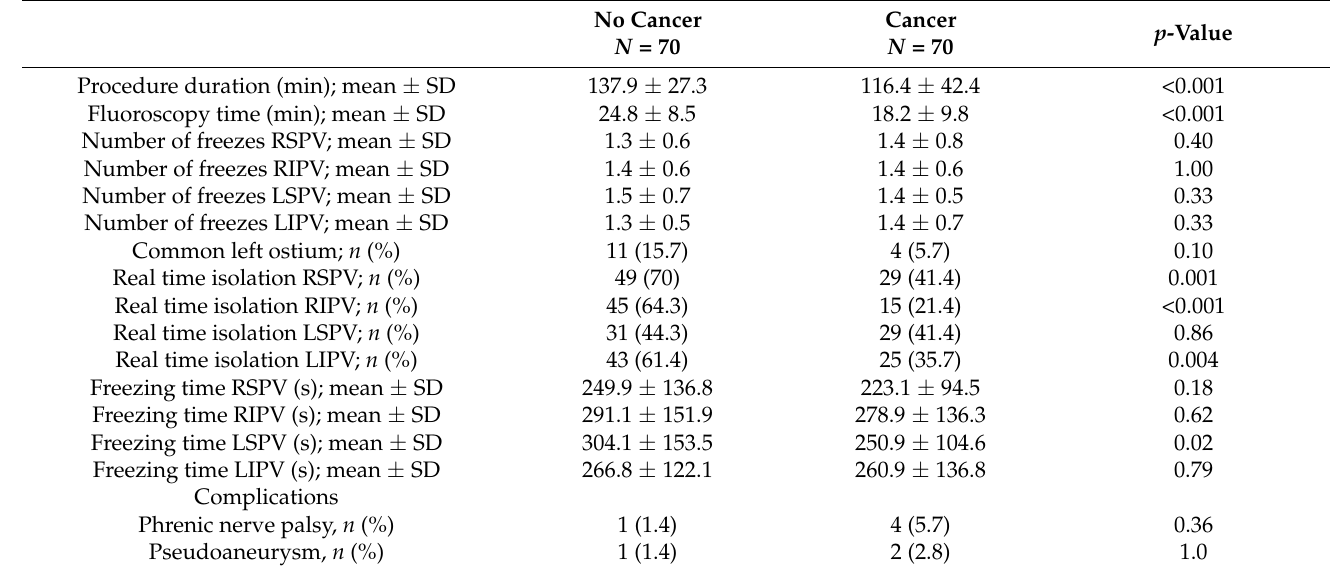
Table 2. Procedural characteristics and complications of patients with and without cancer history.